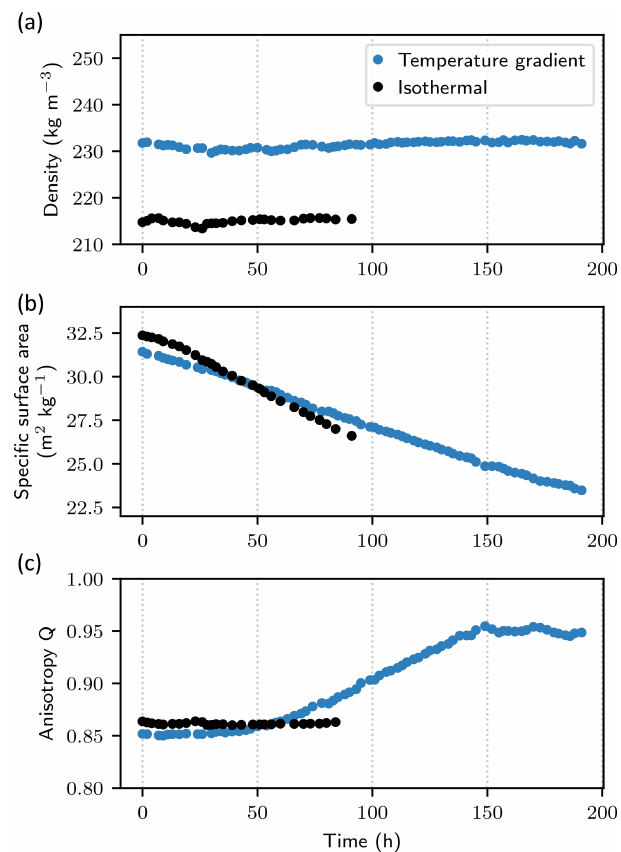
Figure 2. Time evolution of snow density (a) , specific surface area (b) and anisotropy factor Q (c) under the two types of meta-